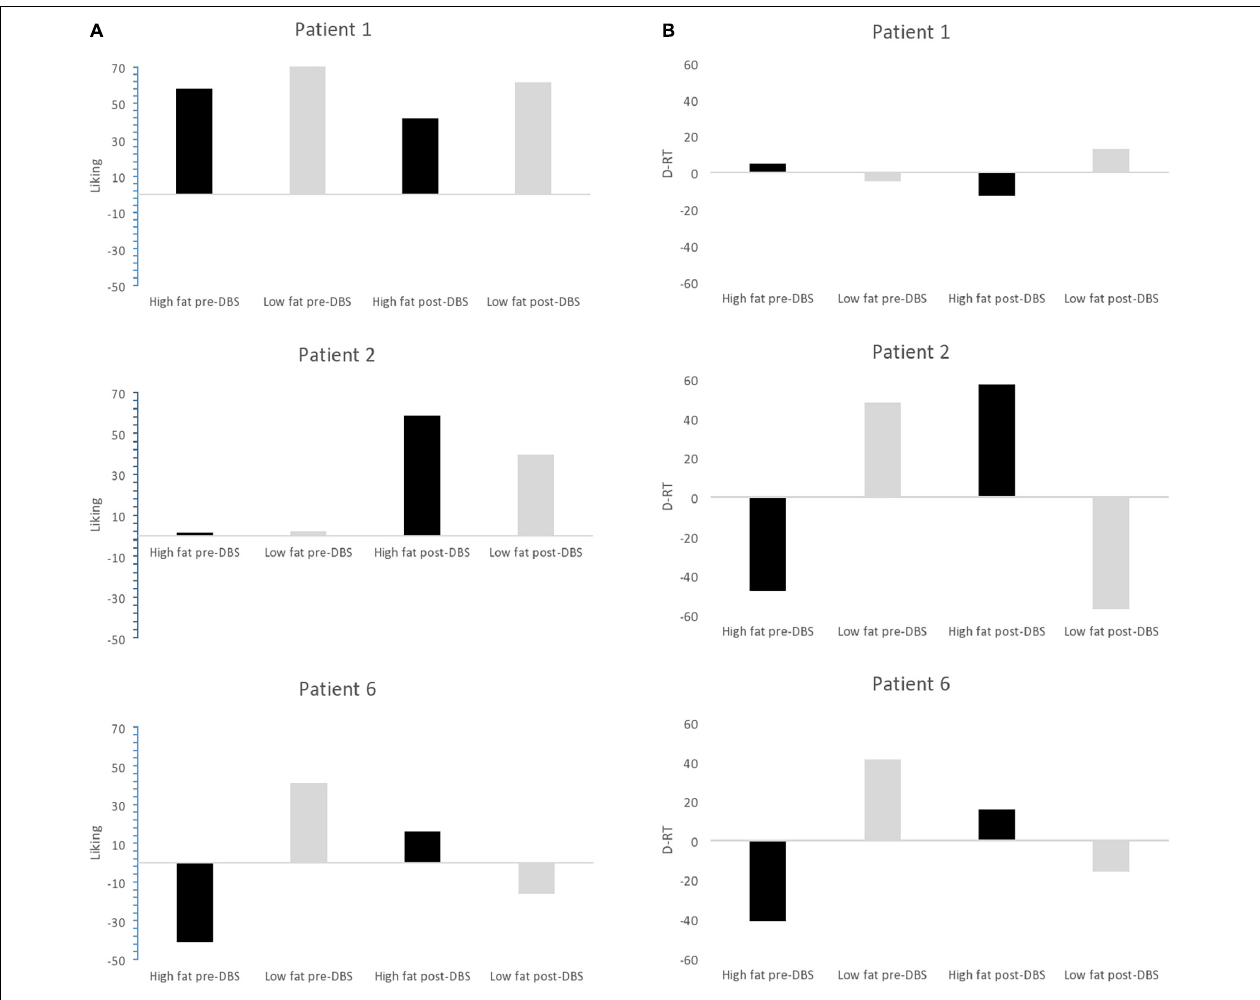
FIGURE 5 | (A) Liking scores for high fat and low fat food pre-DBS and post-DBS in responders. (B) Implicit wanting DRT scores for high fat and low fat food pre-DBS and post-DBS in